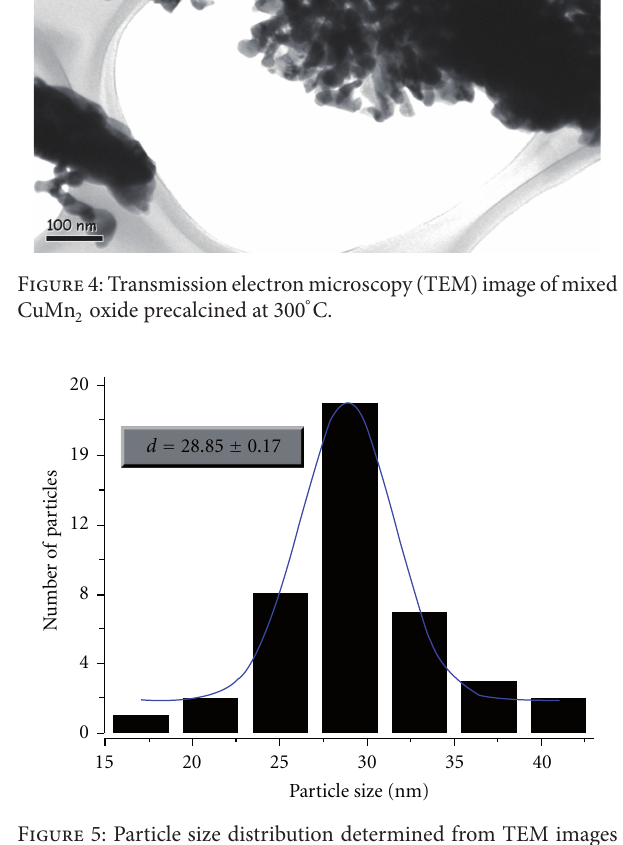
F 5: Particle size distribution determined from TEM images